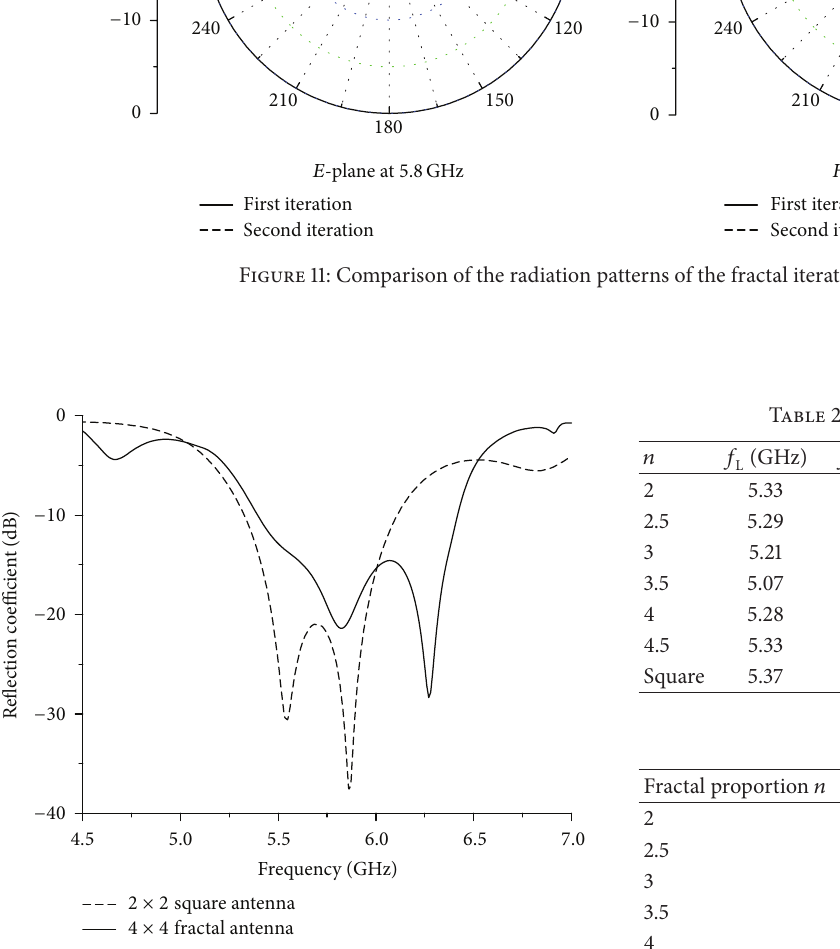
Figure 12: Comparison of the simulated reflection coefficient of the 2 × 2 square patch antenna and the 4 × 4 Giuseppe Peano fractal antenna.